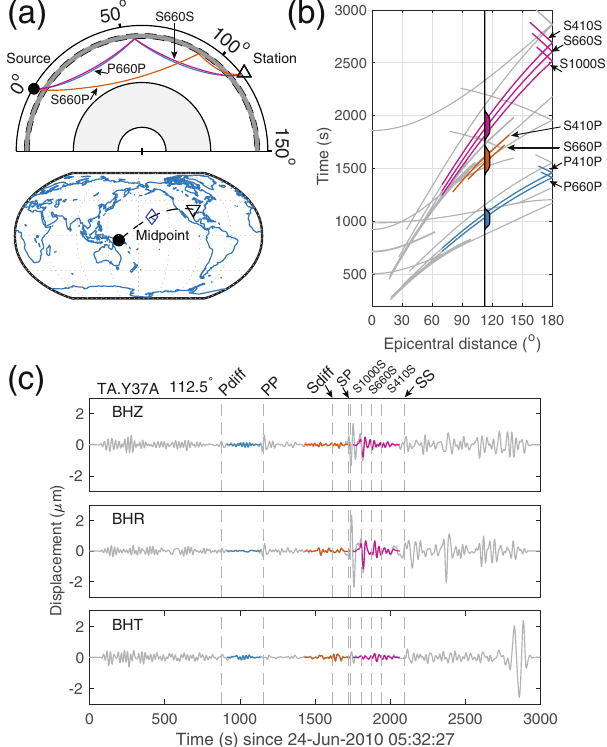
Fig.2|Wavetrajectoriesandtimewindowingofseismicprecursors. Seismicray paths a and travel time-distance curves b of the 410 and 660km-discontinuity (dashed in panel a ) surface-re fl ected precursors, calculated in the 1-D reference model PREM. The selection windows, shown in panel b , are based on the tra- veltimes of the target seismic phases. c Example traces (vertical, radial and trans- versecomponentsdenotedBHZ,BHR,andBHT,respectively)usedforimaging,for the particular case of seismic event C201006240532A, fi ltered between 20 and 100 s. Color coding matches between the panels in this fi